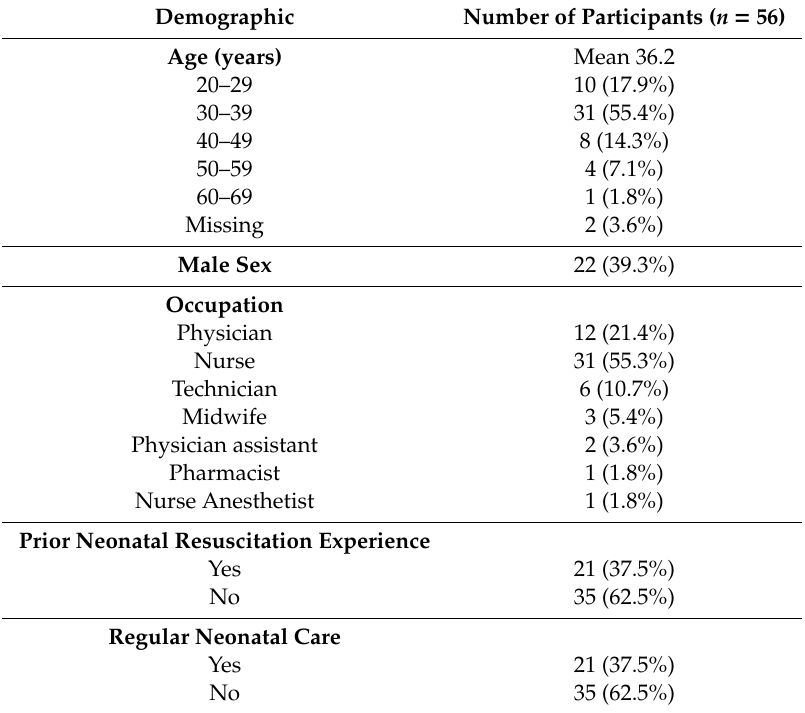
Table 1. Demographics of course